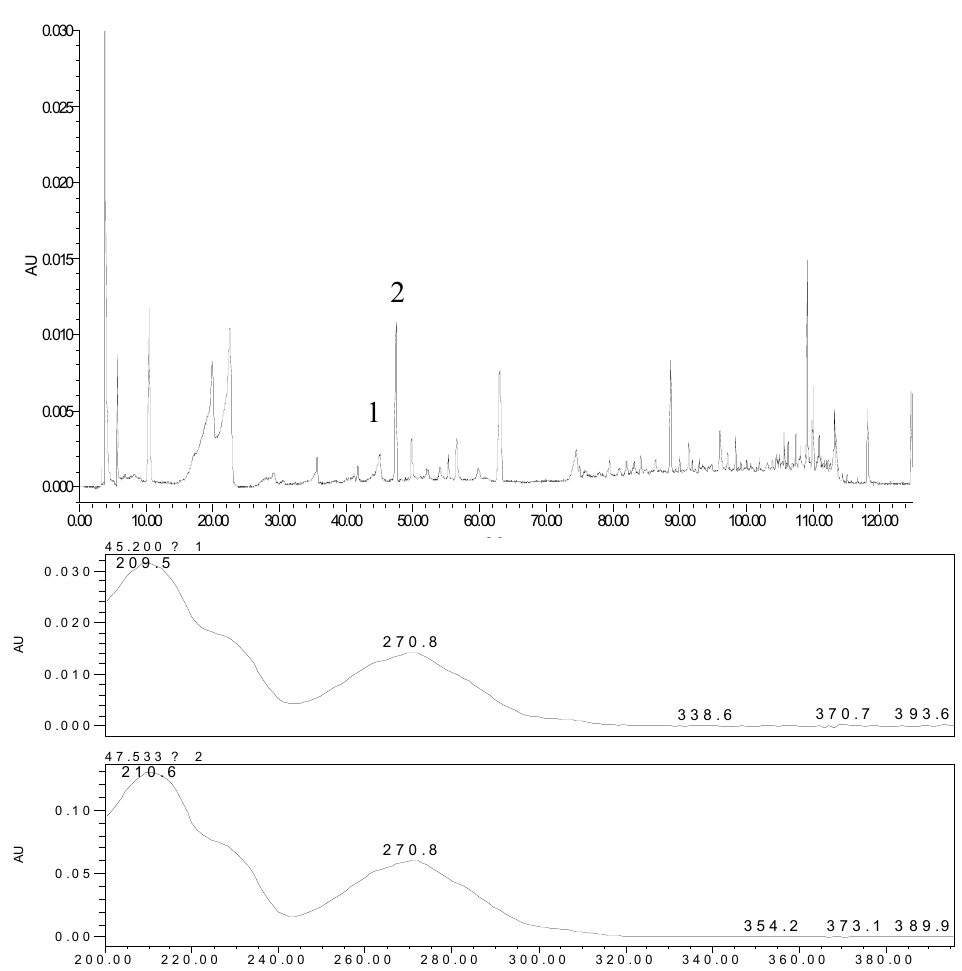
Figure 3. HPLC and UV spectra of the plasma sample after intragastric administration of the alkaloids of Nelumbo nucifera